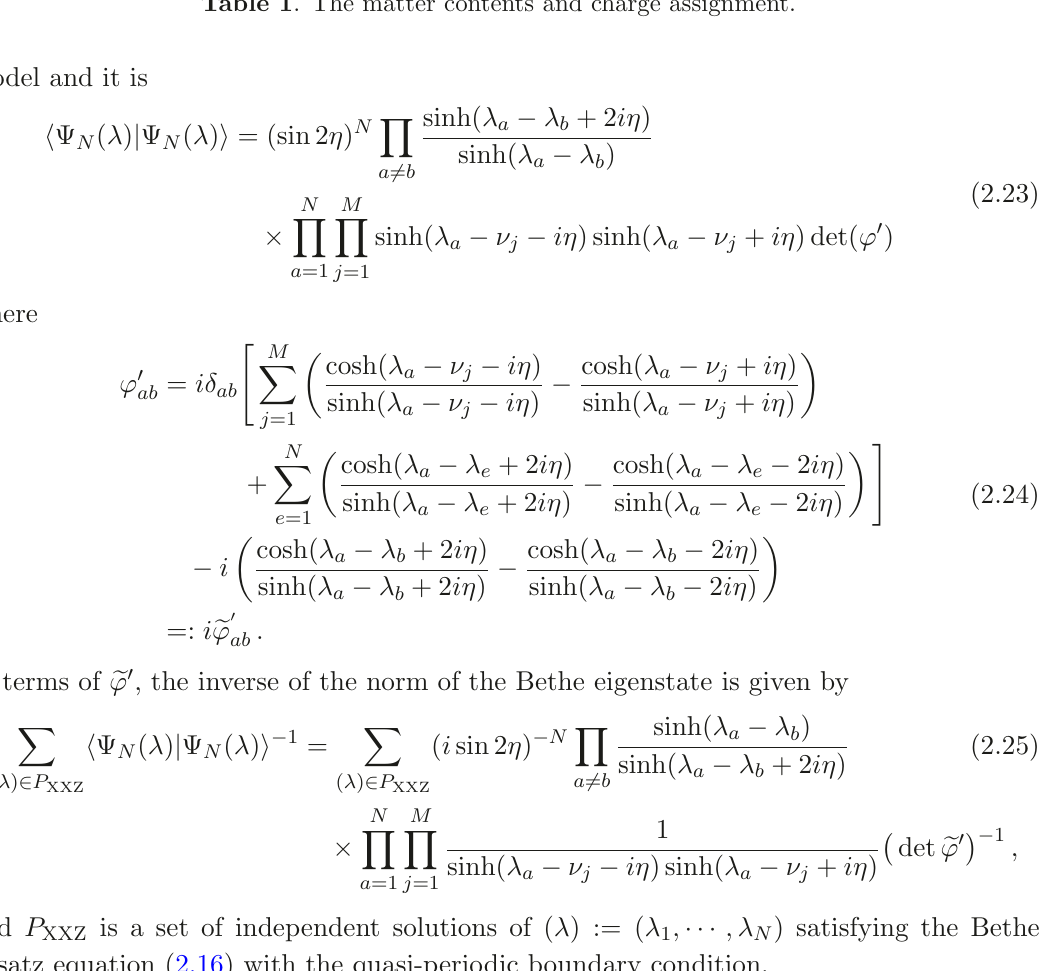
Table 1 . The matter contents and charge